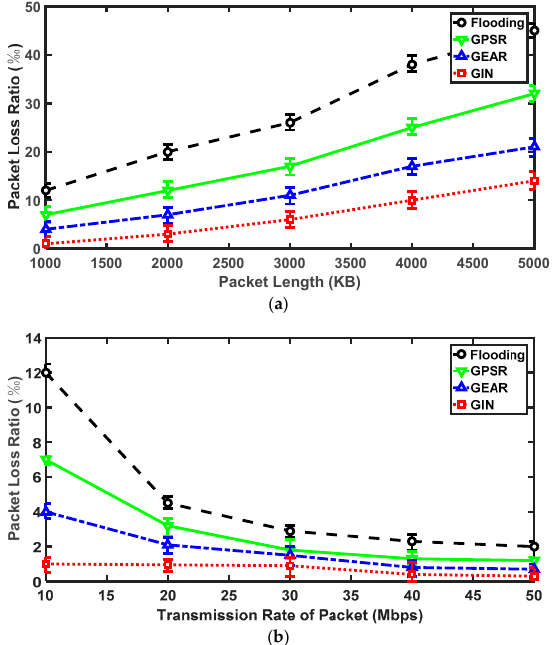
Figure 10. The results for GIN in packet loss ratio. ( a ) Relationships between the packet loss ratio and the packet length; ( b ) Relationships between the packet loss ratio and the transmission rate of packet. As to the throughput aspect, the number of sensor nodes and packet sizes are two significant factors. In Figure 11a, as the number of sensors continue to increase, the throughput of the four protocols gradually declines. For the GIN and GEAR protocols, they have similar trends in throughput, while the GPSR and flooding protocols exist the analogous downward trend. Before the number of nodes hitting 80, the values of the four protocols all fall quickly. However, as the number of nodes exceeding 80, the speeds of decline all becomes smoother. From an overall perspective, GIN protocol outperforms the other three. Particularly in the scenario of 200 nodes co-existing, the value of GIN protocol is still around 120 Mbps, which is about three times that of the flooding protocol and two times that of the GPSR protocol. From Figure 11b, we can arrive at the conclusion that the throughput is proportional to the packet size. The upward trends of the GIN and the GEAR protocols are basically similar. However, the value of the GIN protocol is higher than that of the other three protocols. The gap between the GPSR and flooding protocols gradually increase starting from 1024 KB, where the flooding protocol has the worst performance. The maximum of the flooding protocol is less than the minimum value of the GIN protocol. When the packet size reaches 5120 KB, the throughput of the GIN protocol becomes three times higher than that of the flooding protocol. Due to the IN mechanism, plenty of packets are securely delivered to the event area.